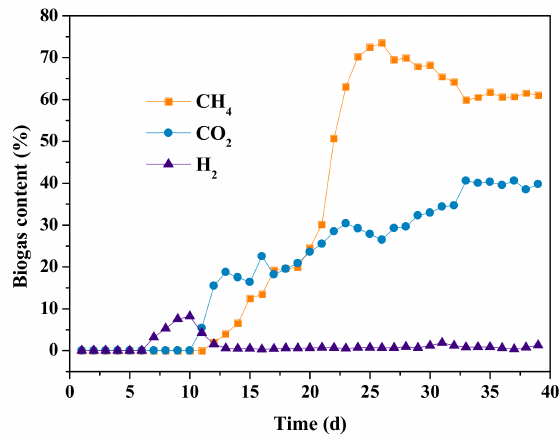
Figure 4. Biogas contents for the anaerobic digestion process in pilot-scale